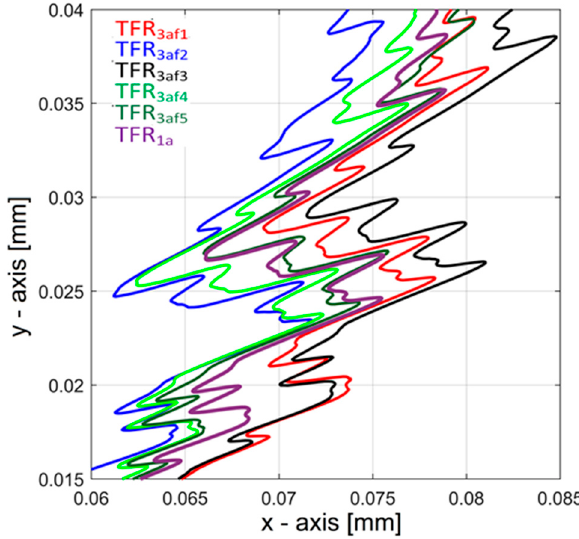
Figure 21. A zoomed in detail of Figure 20 (in B area).